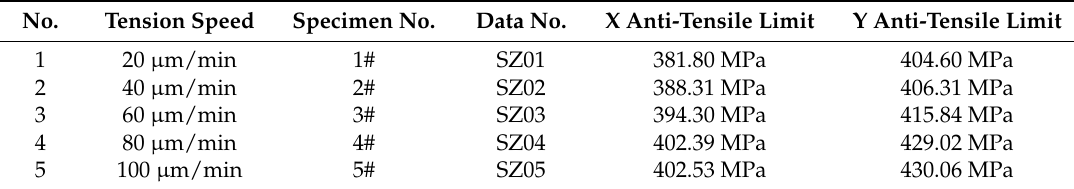
Table 4. The parameters of biaxial tension under different